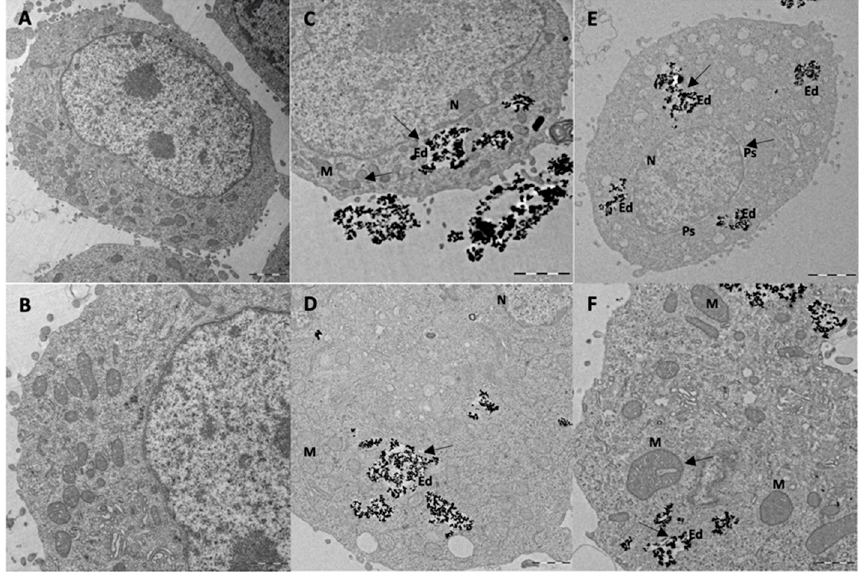
Figure 6. Internalization of BMNPs and Ff35-BMNPs. Ultrastructural alterations produced by Ff35-BMNPs. ( A , B ): Control HepG2 cells. ( C , D) : HepG2 cell exposed to BMNPs has ultrastructure similar to control cells. ( E,F ): Treatment with Ff35-BMNPs (concentration of BMNPs was 300 μ g mL − 1 and